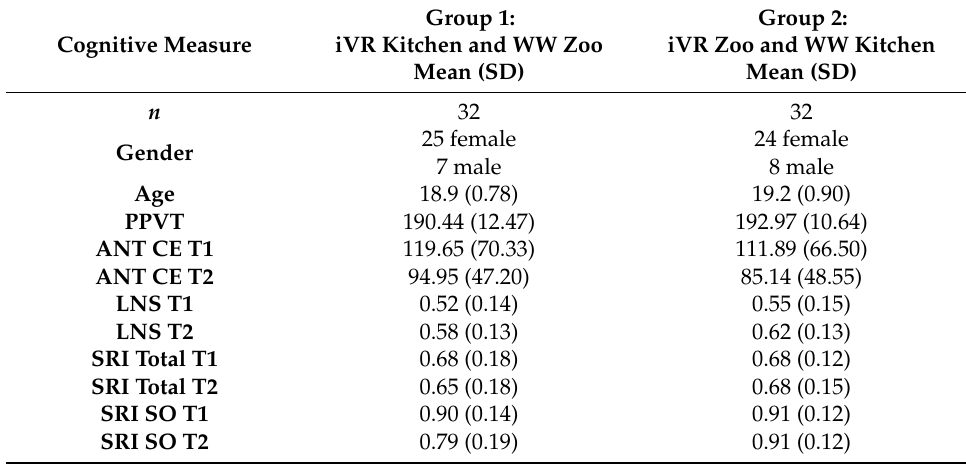
Table 4. Overview of cognitive performance. Overview of participant population ( n ) and means and standard deviations (SD) for the English Peabody Picture Vocabulary Test (PPVT), attentional network task conflict effect (ANT CE) at pre-test (T1) and post-L2 training test (T2), letter number sequencing (LNS) working memory L2, and overall spatial reasoning instrument (SRI) performance as well as performance on spatial orientation (SRI SO) sub-questions across immersive virtual reality (iVR) and word-word association (WW) learning groups.